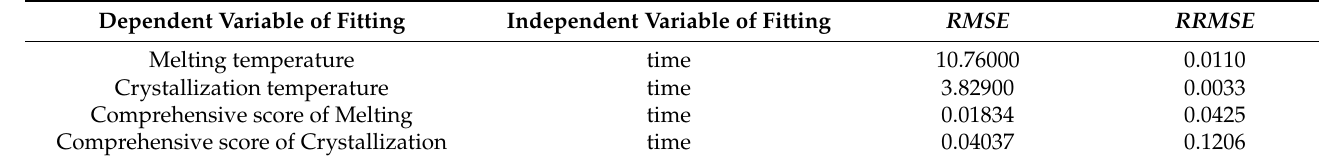
Table 7. RMSE and RRMSE values for all fitting methods used in this